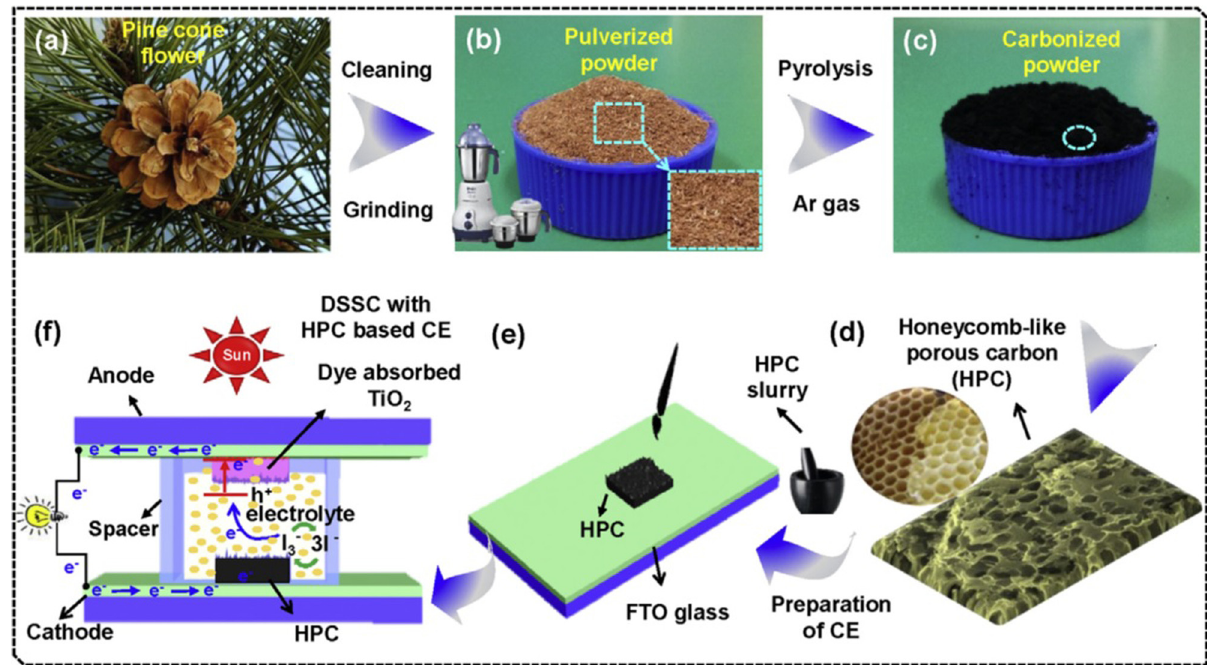
Figure 8: Schematic of ( a – d ) porous AC fabrication and ( e – f ) dye - sensitized solar cell preparation process with porous AC - coated FTO glass. Copied with permission from ref. [ 39 ] ; Elsevier,